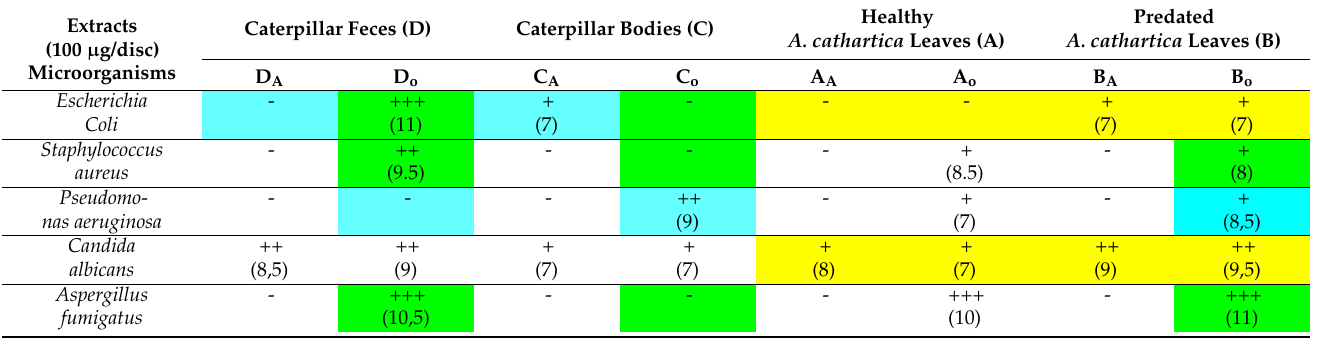
Table 2. Microbial activity results of aqueous and organic extracts, obtained from Allamanda cathartica ( A. cathartica ) leaves, caterpillar bodies and caterpillar feces on three bacterial ( Escherichia coli ; Staphylo- coccus aureus ; Pseudomonas aeruginosa ) and two fungal ( Candida albicans ; Aspergillus fumigatus )